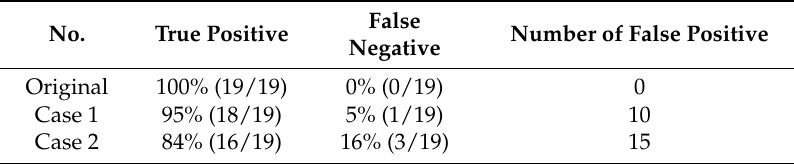
Table 7. Quantitative comparison of the three cases.